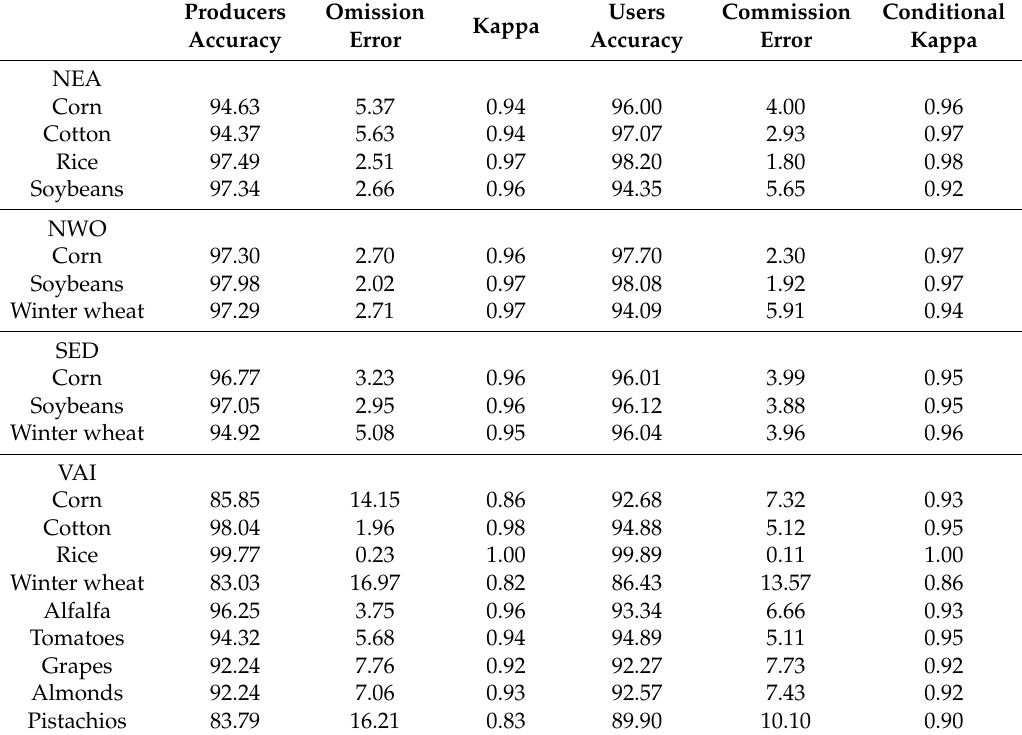
Table 2. The cropland data layer accuracies statistics for major crops across four case study